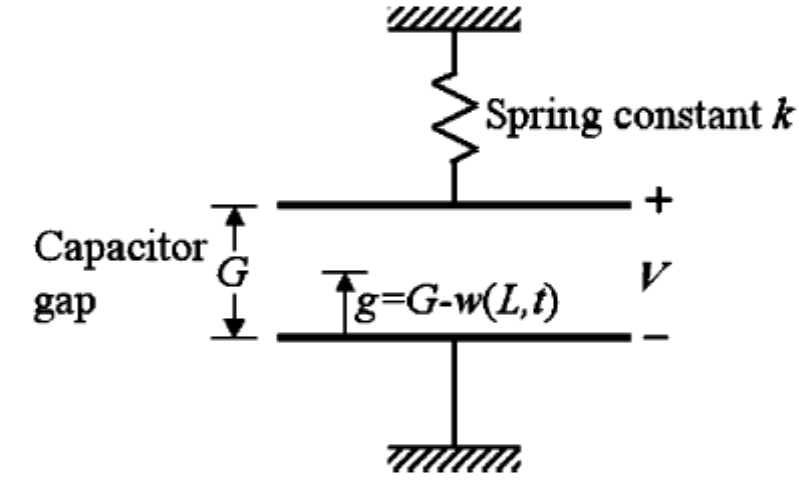
Figure 3. A discrete model of an equivalent spring and a parallel-plate capacitor